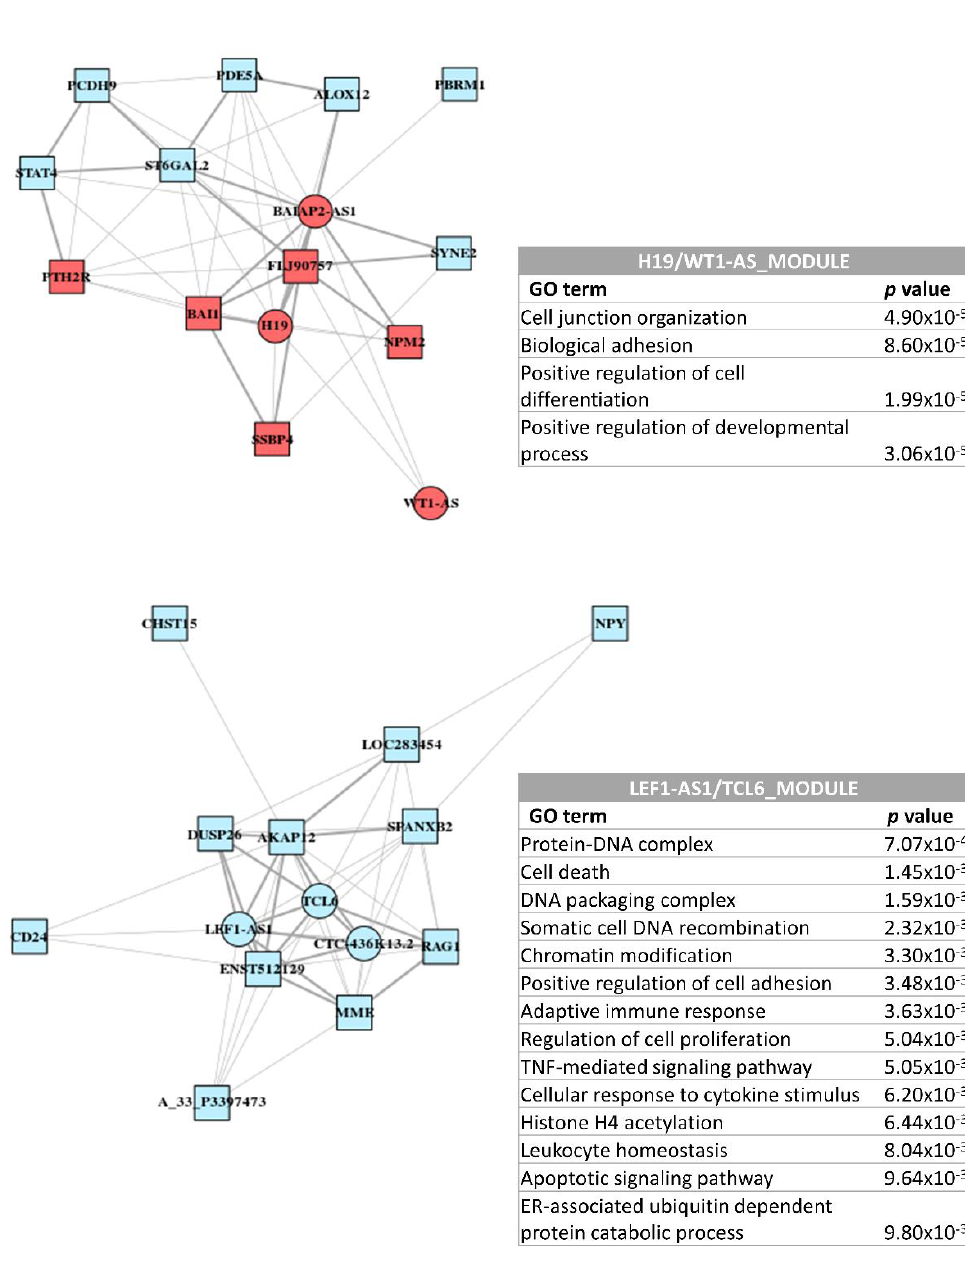
Figure 6. Coexpression network formed around H19, WT1-AS, LEF1-AS1, and TCL6 lncRNAs. The computational process generated two modules for the H19/WT1-AS and LEF1-AS1/TCL6 lncRNA pairs.